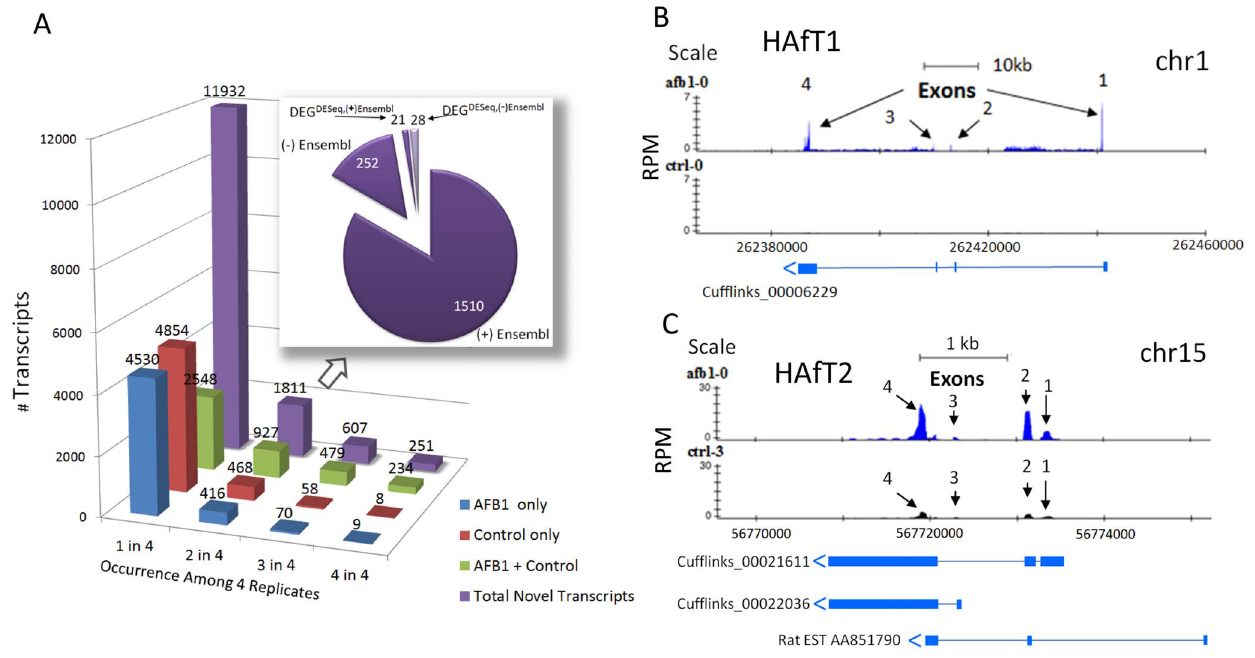
Figure 4. Novel transcripts found by RNA-Seq. Panel A. Bar graph shows the number of total and potentially novel transcripts on the Y-axis. Transcripts are shown for Total (purple), unique to either AFB1 (blue) or Control (red), and common (AFB1 + Control, green), according to the occurrence among replicates on the X-axis. A further breakdown of the 1811 total transcripts observed in two or more replicates is shown in the pie chart. Here, the majority of 1811 transcripts had some Ensembl annotation (1531) while the rest did not (280). Of those that were differentially expressed by AFB1, 21 had Ensembl annotation while 28 were unannotated and therefore, novel DEG transcripts. Panels B and C show two such novel transcripts, described here as ‘HAfT-1’ and ‘HAfT-2’ (Hepatic Aflatoxin-responsive Transcripts 1 and 2). Numbers of reads as RPM are shown on the Y-axis and the genomic region is displayed on the X-axis for representative AFB1 (blue reads) and CTRL (black reads) sample tracks in UCSC browser format. See text for more